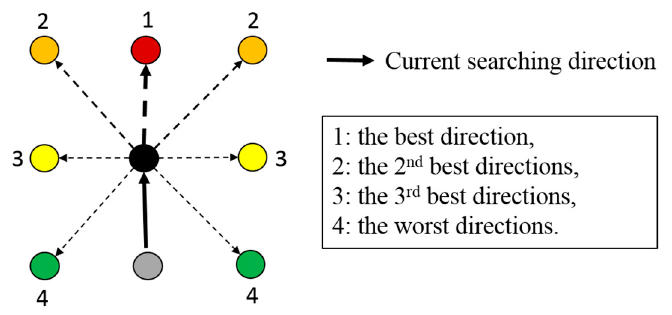
Figure 5. Searching priorities in the depth-first-search on a contour graph.